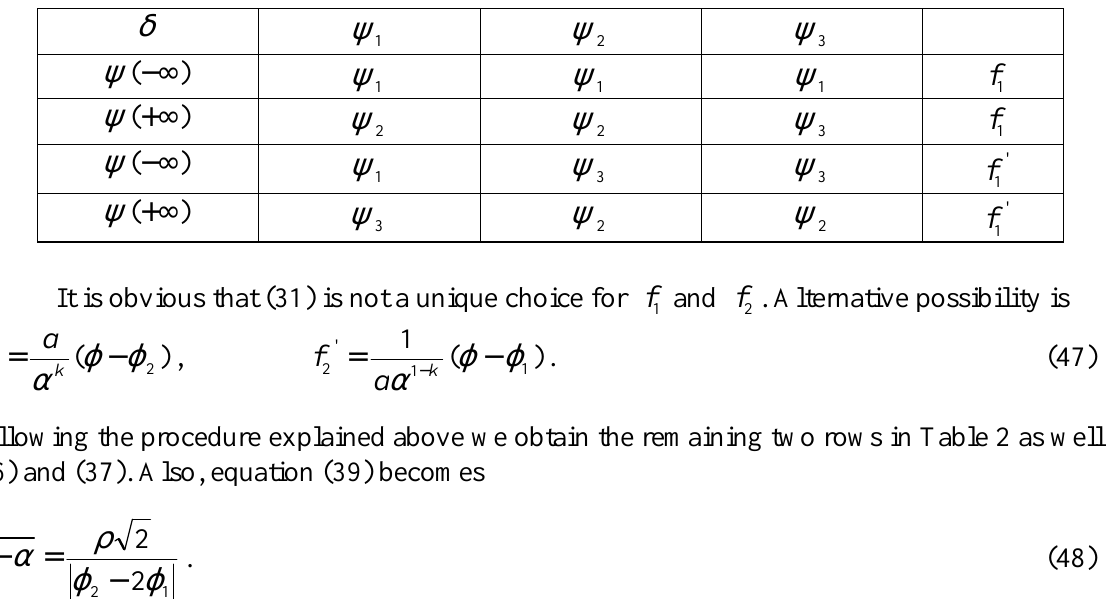
)( xy for all three values of d